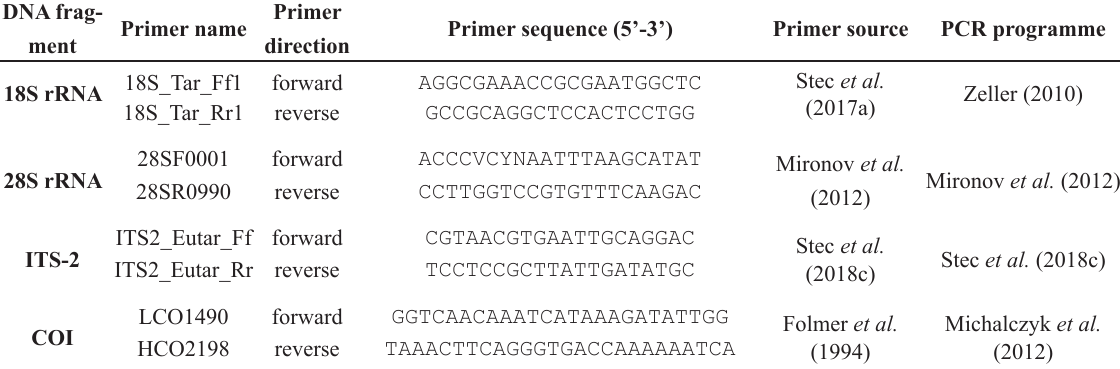
Table 2. Primers and references for PCR protocols for amplification of the four DNA fragments sequenced in the